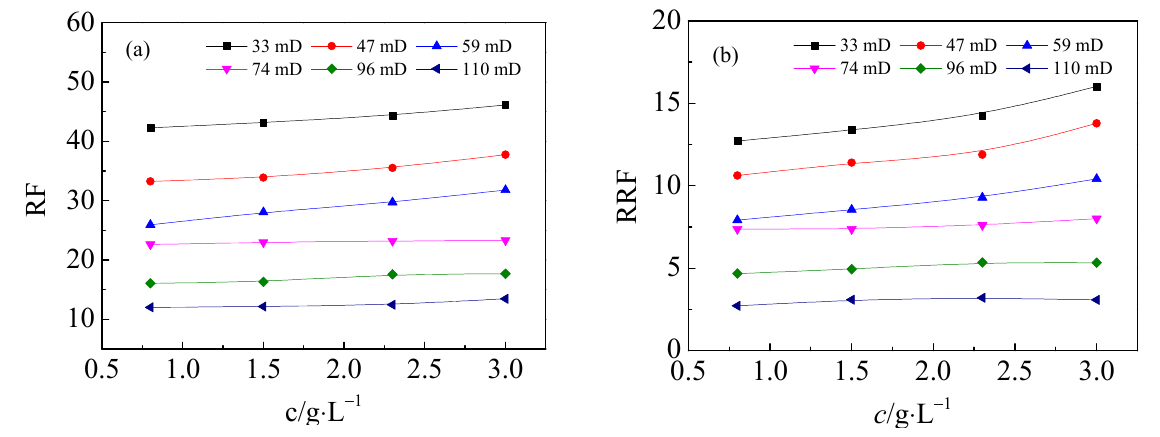
Figure 6. The dependence of ( a ) the resistance factor (RF) and ( b ) the residual resistance factor (RRF)